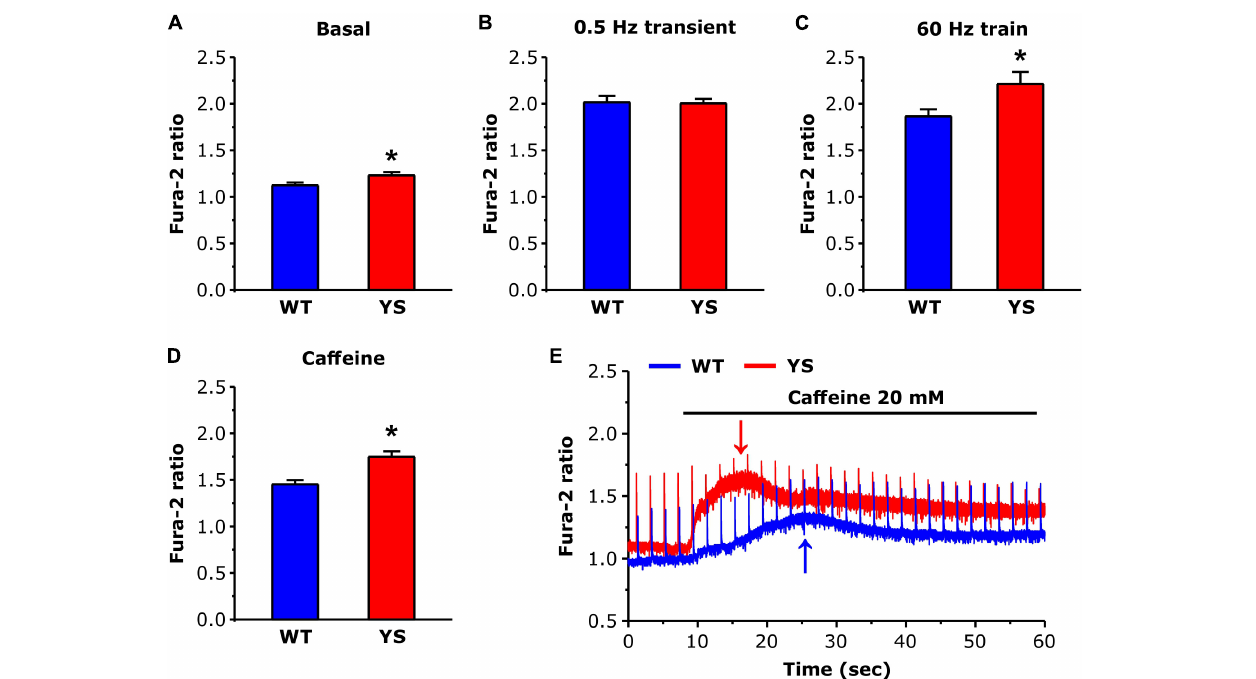
FIGURE 1 | Cytosolic free Ca 2 + concentrations at rest and during contraction as determined by Fura-2. (A) Basal resting Ca 2 + levels during low frequency stimulation at 0.5 Hz. (B) Ca 2 + levels at the peak of transients elicited by electrical stimulation at 0.5 Hz (average of 10 transients in each fiber). (C) Values of Ca 2 + levels reached at the end of a train of electrical stimulation at 60 Hz, 2 s duration (average of the last 100 ms). (D) Values of basal Ca 2 + levels reached at the first peak after exposure to 20 mM caffeine. (E) Representative recordings of Fura-2 fluorescence ratio in WT and YS fibers during caffeine administration, note that the first peak of basal Ca 2 + concentration (pointed by arrows) occurs earlier and is higher in YS compared to WT muscle fibers and that in YS fibers the basal Ca 2 + concentration remains high. Data are shown as means ± SEM; ∗ p < 0.05. Panels A–C : n = 33 WT and 33 YS fibers; panel D : n = 13 WT and 13 YS fibers.